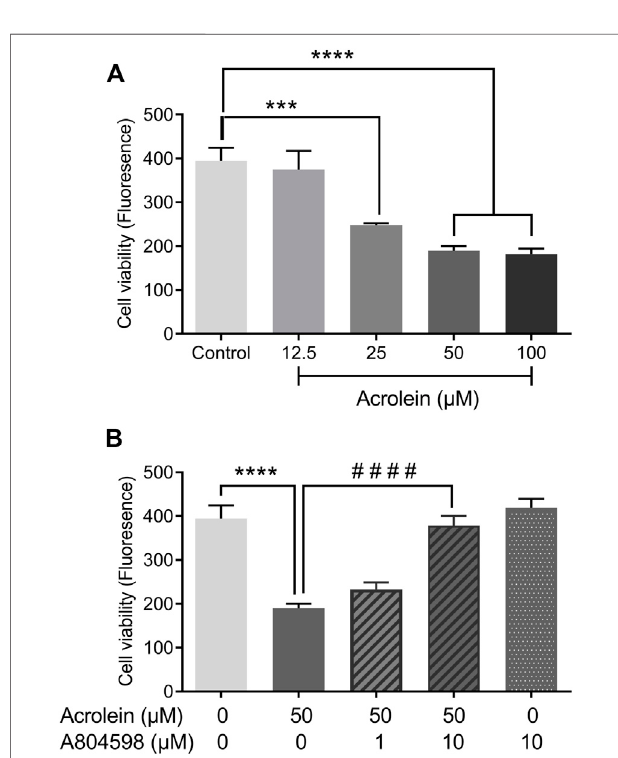
FIGURE 2 | Effects of P2X7R inhibition on acrolein-induced cytotoxicity as measured by oxidation of resazurin. (A) Acrolein reduced urothelial cell viability in a concentration-dependent manner (12.5 – 100 µM). (B) The reduced cell viability caused by acrolein (50 µM) was prevented by the addition of P2X7R antagonist A804598 at 10 μ M, although the preventive effect was not signi fi cant at a lower concentration (1 µM). A804598 (10 µM) alone showed no different compared to the control. *** p < 0.001, **** p < 0.0001 compared to the control; #### p < 0.0001 compared to the acrolein treated group ( n = 6 for all groups, one-way ANOVA followed by Bonferroni ’ s multiple comparisons.